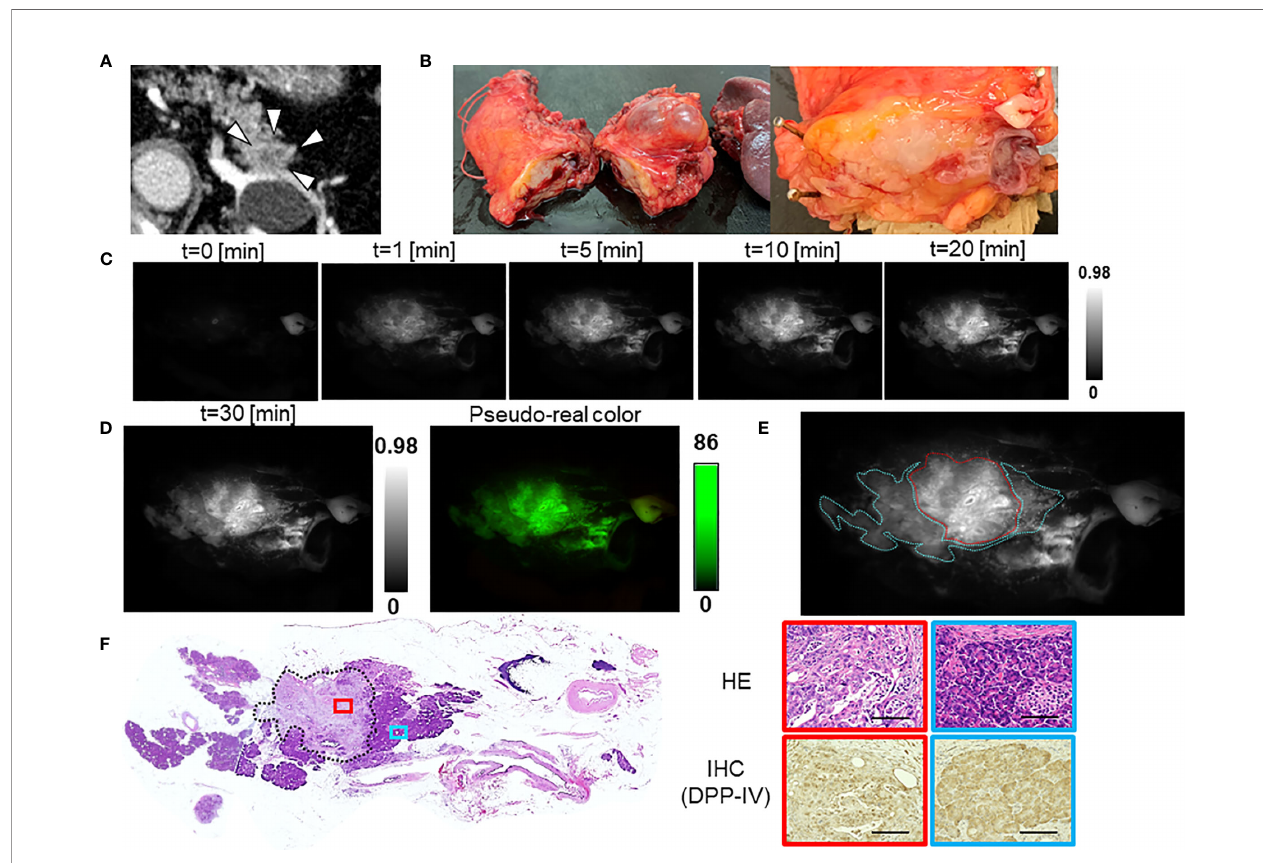
FIGURE 2 | Fluorescence imaging using GP-HMRG to analyze whole surgical specimens demonstrated homogenous increases in fl uorescence signals emitted by pancreatic cancer tissues (Patient No. 2). (A) Preoperative contrast-enhanced computed tomography of pancreatic tail cancer (arrowheads). (B) Macroscopic image of the DP specimen after making cut surfaces of the tumor in the operation room (left). Right indicates magni fi ed view of the cut surface including the tumor. (C) Increase of fl uorescence signals after spraying GP-HMRG on the cut surface. (D) Fluorescence image (left) and its pseudo-real color image (right) of the cut surface 30 min after probe administration. (E) Relationships between fl uorescence signals and distributions of cancer tissues (red dotted line) and surrounding pancreatic tissues (blue dotted line) according to histological fi ndings. (F) Low-magni fi cation histopathological image of hematoxylin – eosin (H&E) staining corresponding to fl uorescence images (left, dotted line indicates cancer boundaries). Magni fi ed views of H&E staining and IHC analysis of DPP-IV in cancer (red) and pancreatic (blue) tissues (right). Scale bar = 100